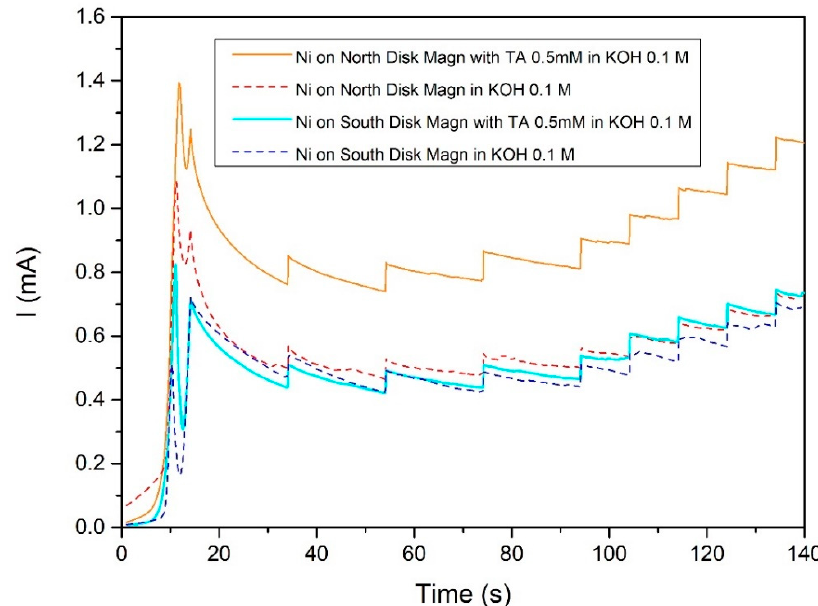
Figure 8. Step and sweeps curves recorded on a Ni deposited on magnet working electrode, a Pt sheet is the CE, Ag / AgCl / KCl is the RE. KOH 0.1 M aqueous solution the base electrolyte. First a potential ramp from 0 to 0.70 V at a 50 mV / s was applied, followed by eight + 0.01 V potential steps, up to 0.78 V. The potential was maintained constant for 15 s between each step. l -( + )-tartaric acid concentration: ( blue dash ) South mag orientation 0 mM, ( red dash ) South mag orientation 0 mM, ( light blue ) South mag orientation 0.5 mM, ( orange ) North mag orientation 0.5 mM.